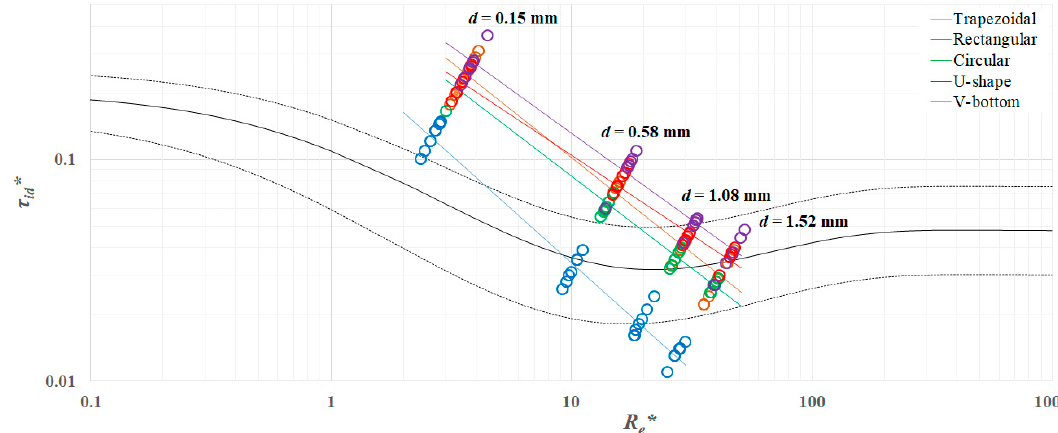
Figure 3. Relationship between the incipient deposition shear stress and Reynolds number based on the Shields method (circles show values calculated from the measurements, lines are the fitted equations).